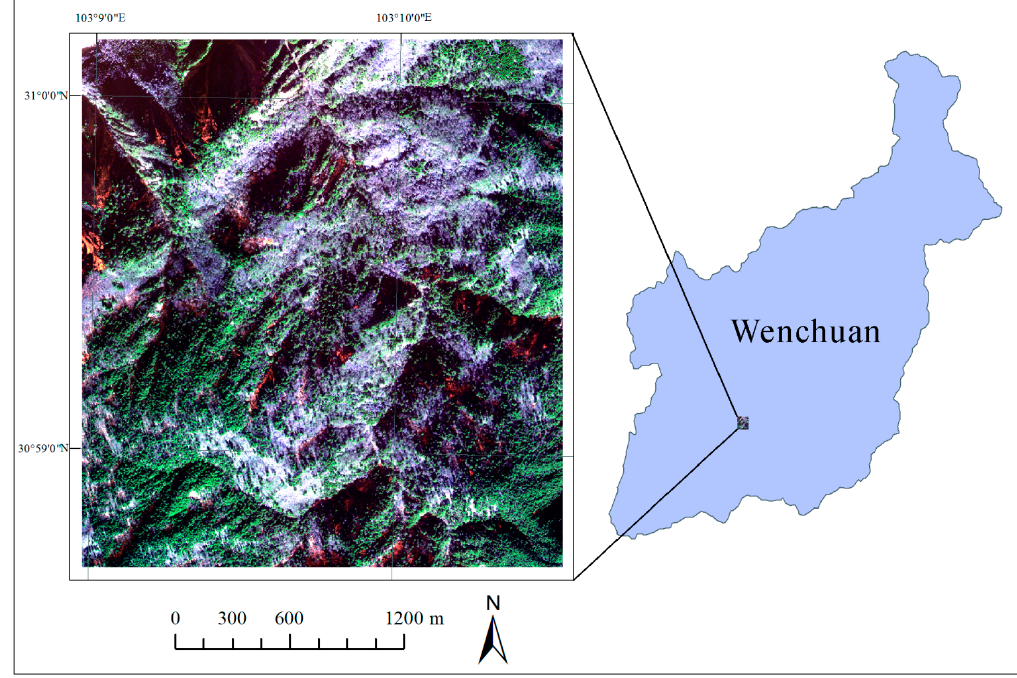
Figure 1. The study area in Wuyipeng (the true color composition of the WV-2 MS Bands 5, 3 and 2 as red, green and blue channels, respectively).